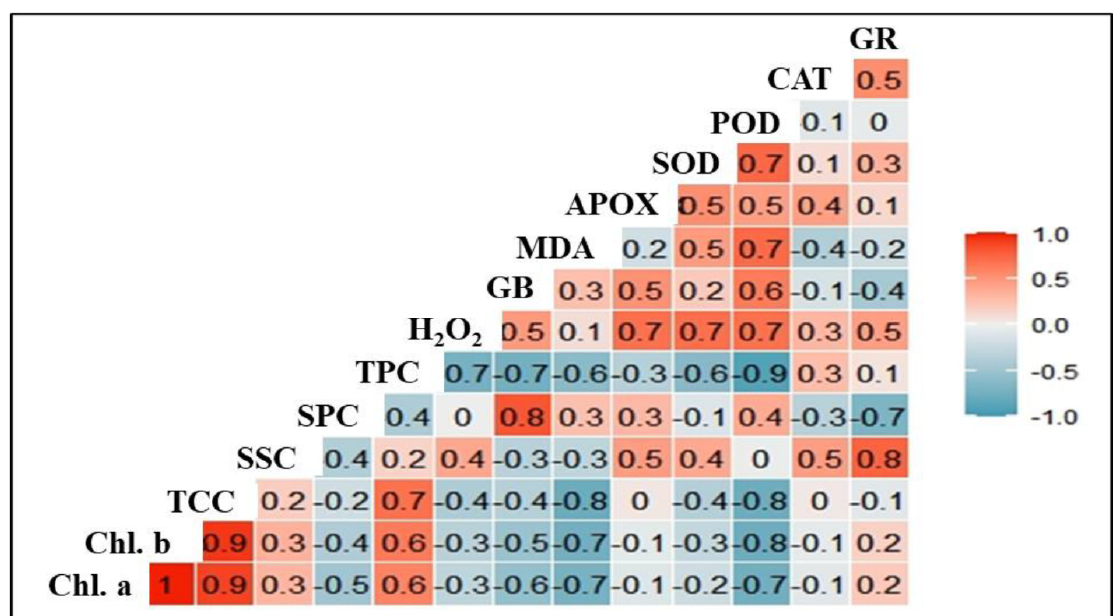
Figure 4. Effect of AsA and/or α -toc on superoxide dismutase (SOD), peroxidase (POD), ascorbate peroxidase (APOX), catalase (CAT), or glutathione reductase (GR) of A. sativa under drought stress. Different alphabetical letters indicate significant differences among treatments at p < 0.05, according to the LSD test. (T0) control: normal watering + 0 mg AsA and α -toc, (T1): 15 days drought + 0 mg AsA and α -toc, (T2): 15 days drought + 200 mg AsA, (T3): 15 days drought + 200 mg α -toc, (T4): 15 days drought + 200 mg AsA and α -toc, (T5): 25 days drought + 0 mg AsA and α -toc, (T6): 25 days drought + 200 mg AsA, (T7): 25 days drought + 200 mg α -toc, (T8): 25 days drought + 200 mg AsA and α -toc.